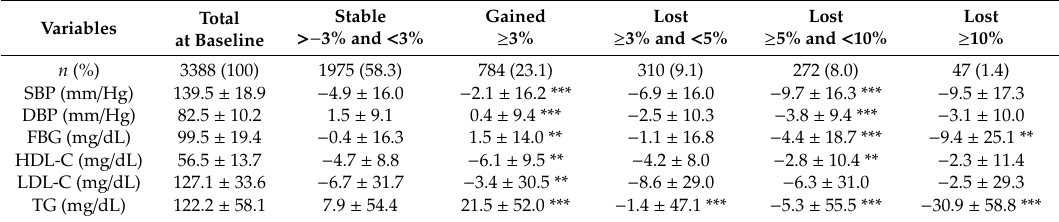
Table 2. Changes in CVD risk factors from baseline to two-year follow-up, stratified by the weight change categories.